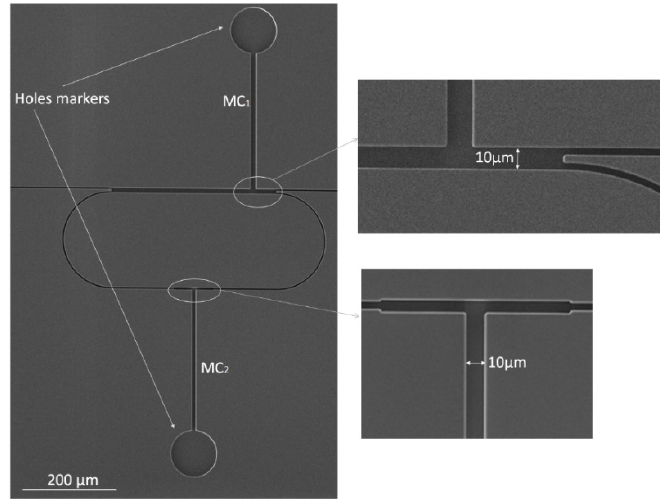
Figure 8. SEM image of the fabricated silicon-based part of the chip.